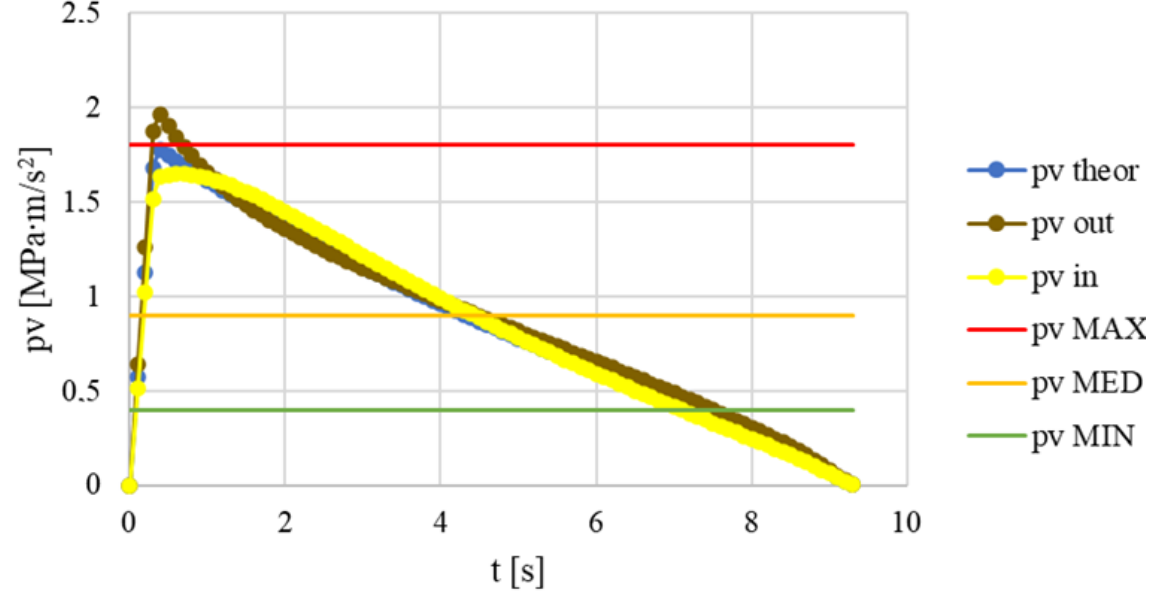
Figure 5. pv levels during simulation model operation at inner ( pv in), outer ( pv out) and middle ( pv theory) diameters and MAX-MED-MIN pv values used for pin-on-disk measurements.